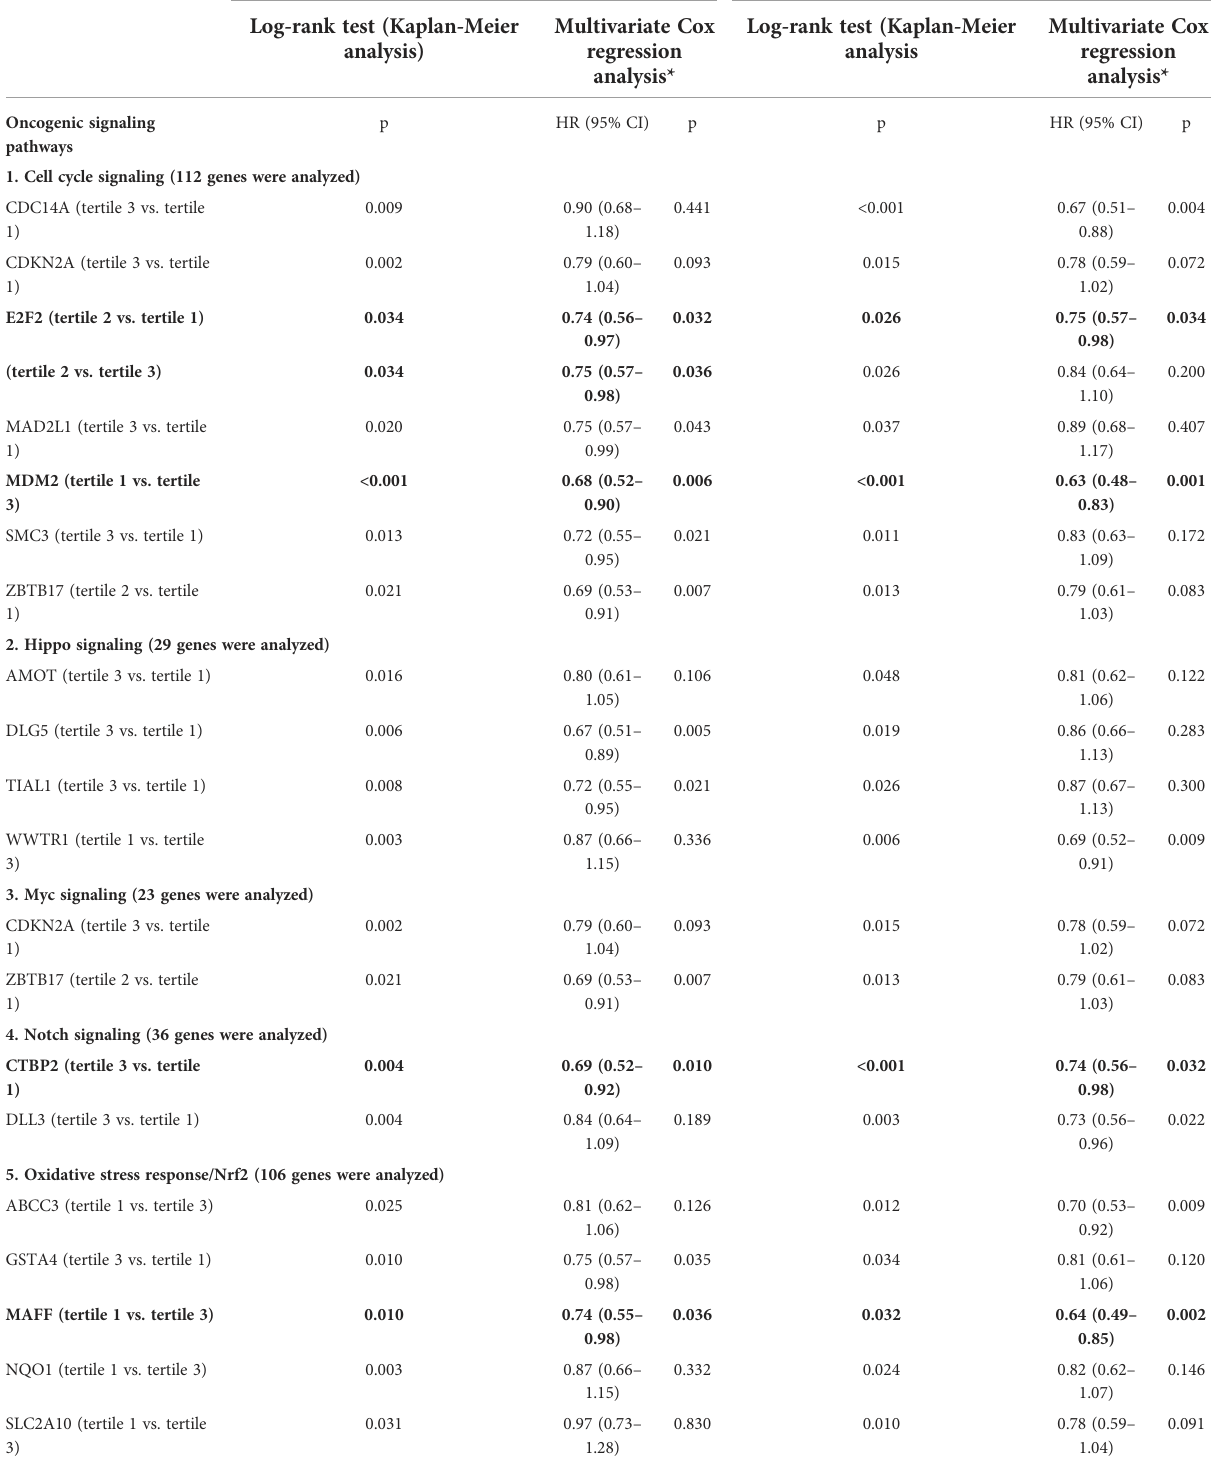
TABLE 2 Multivariate Cox analyses of genes signi fi cantly associated with overall survival and progression-free survival in GBM patients related to 10 oncogenic signaling